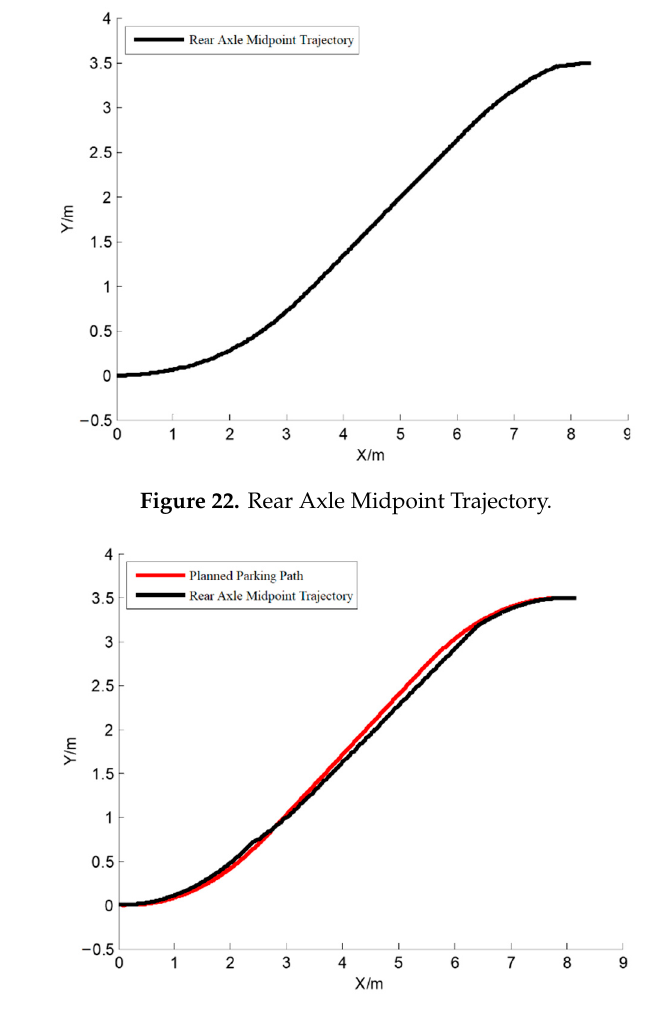
Figure 23. Actual Path Tracking Effect.